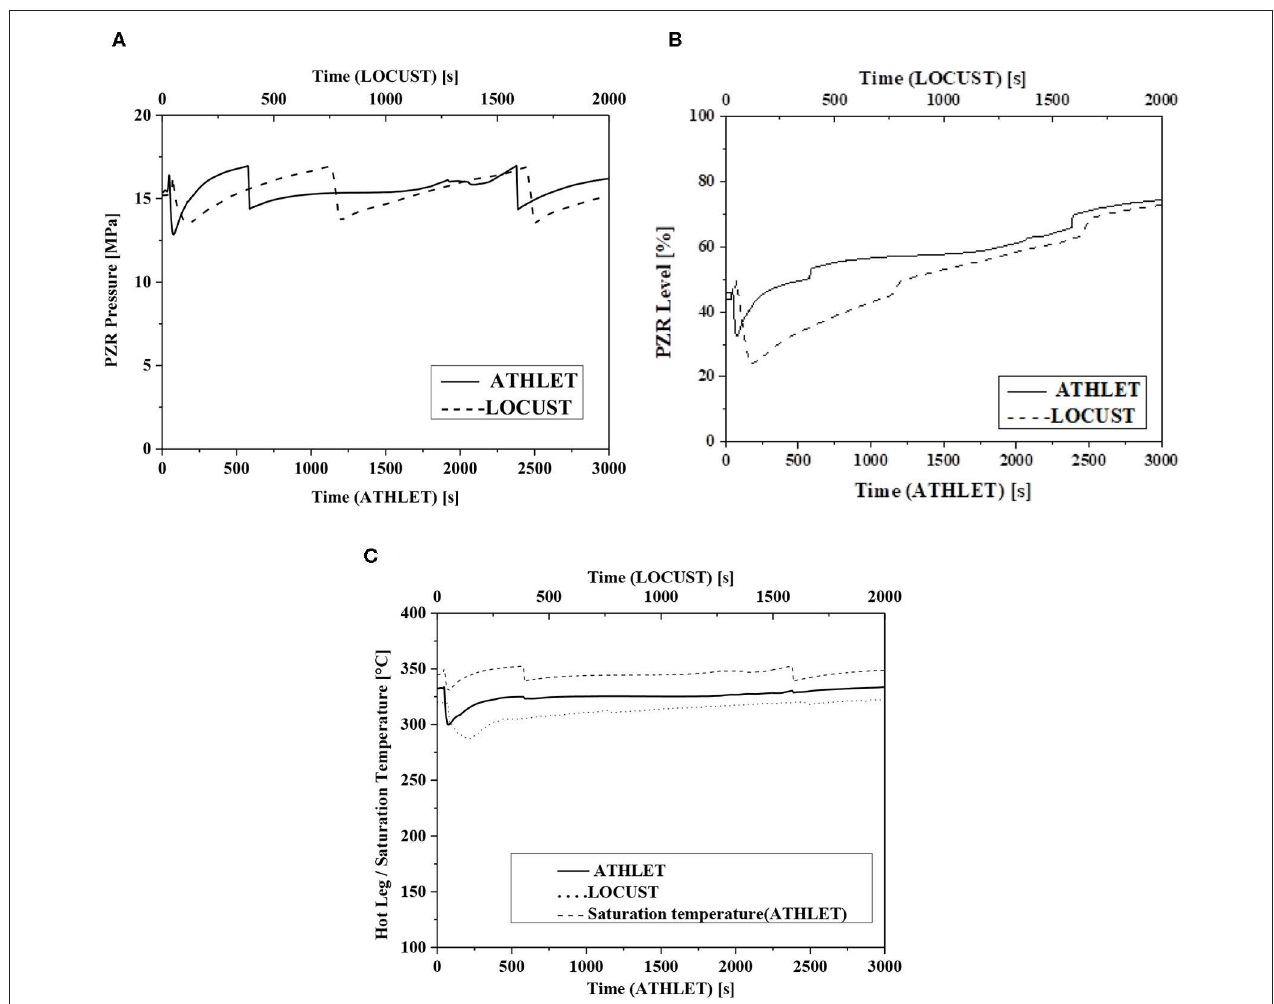
FIGURE 9 | Simulation results of FLB for HPR1000. (A) PZR pressure history. (B) The change of PZR level. (C) The change of hot-leg